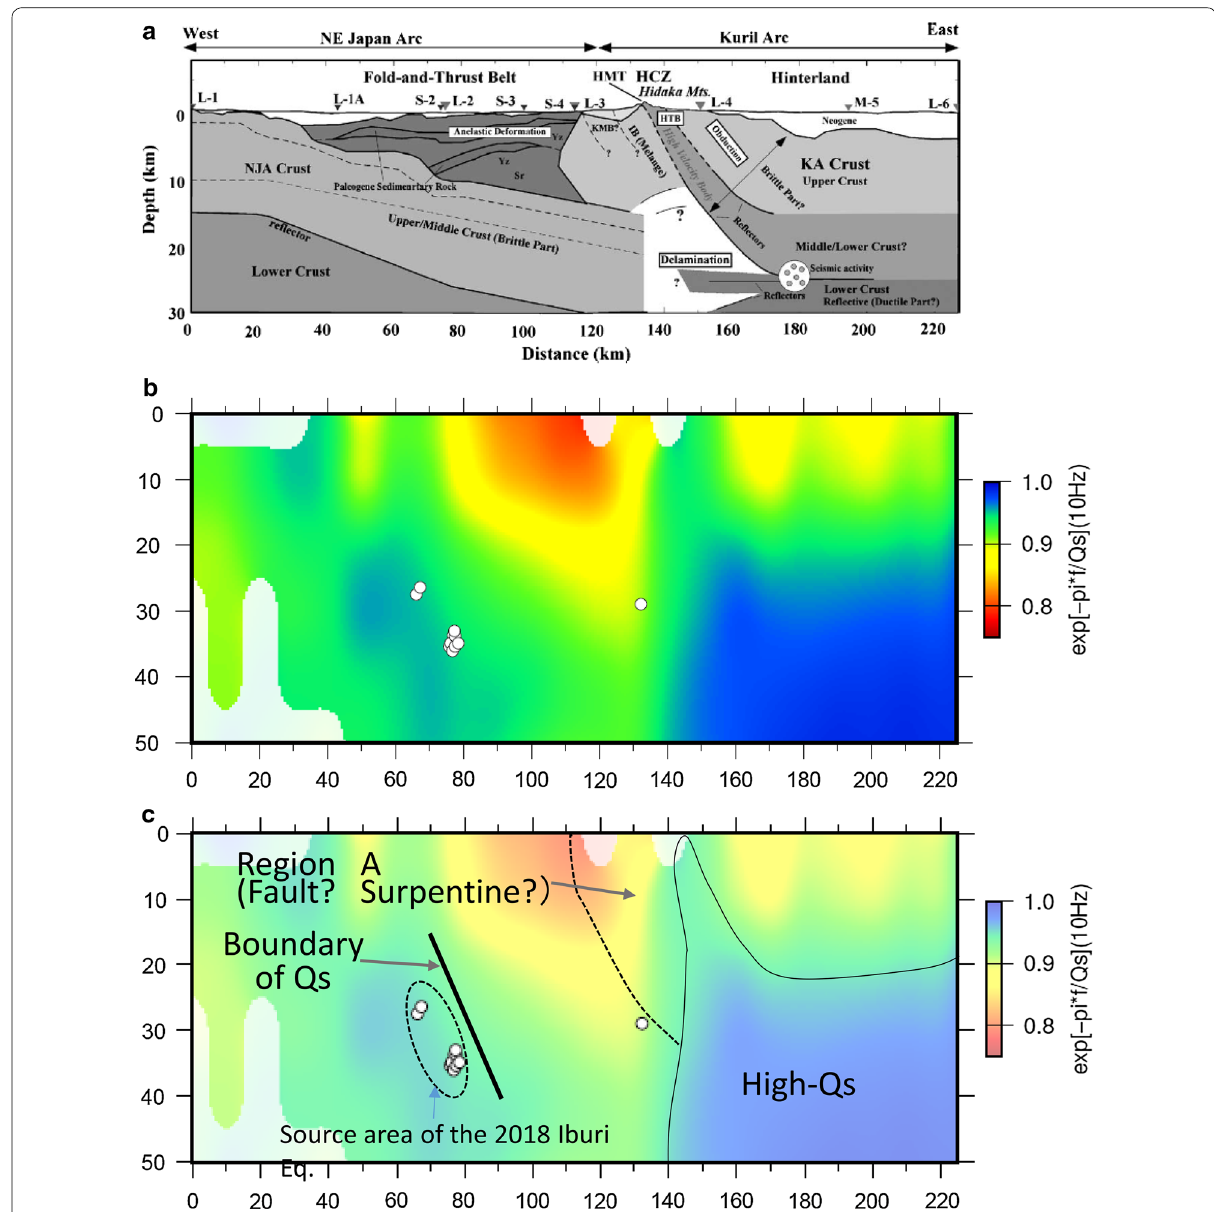
Fig. 5 Comparisons and interpretations of the estimated Qs structure in this study. a The crustal structure across the collision zone between the Kuril and the northeastern Japan arcs interpreted by Iwasaki et al. (2004). b , c The Qs estimated structure in this study and its interpretations. A location of the cross-section is included in Fig. 4b. The vertical length is enlarged by 2. The color scale is the same in Fig.